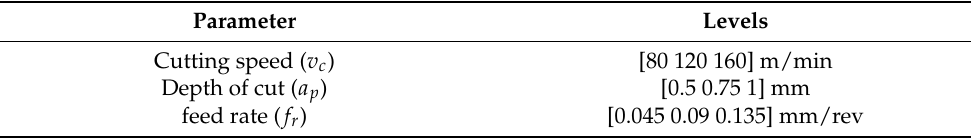
Table 5. Running-condition parameters and their